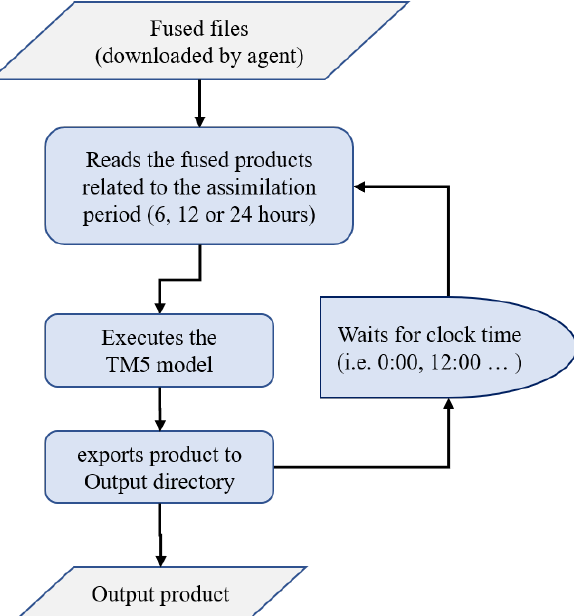
Figure 8. High level flow chart of the Assimilation